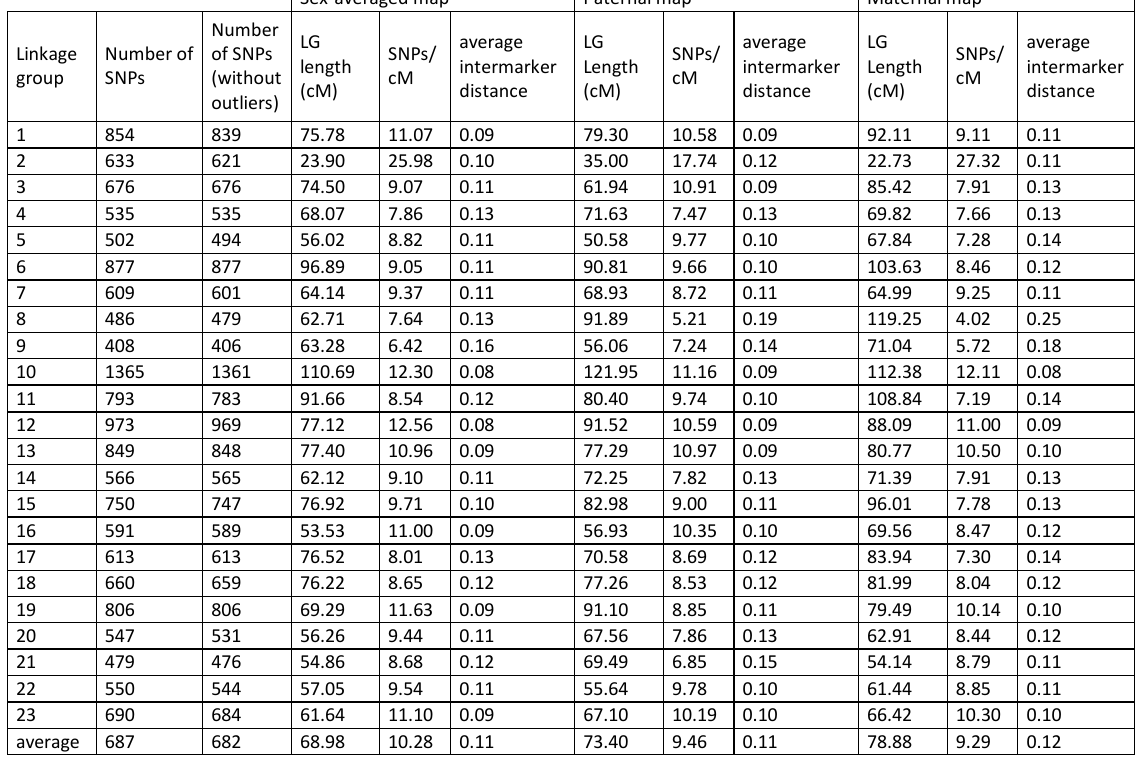
Table 1. Comparison of the sex-averaged, male and female linkage maps. The values in this table are computed without the outliers SNP markers at the extremity of the linkage